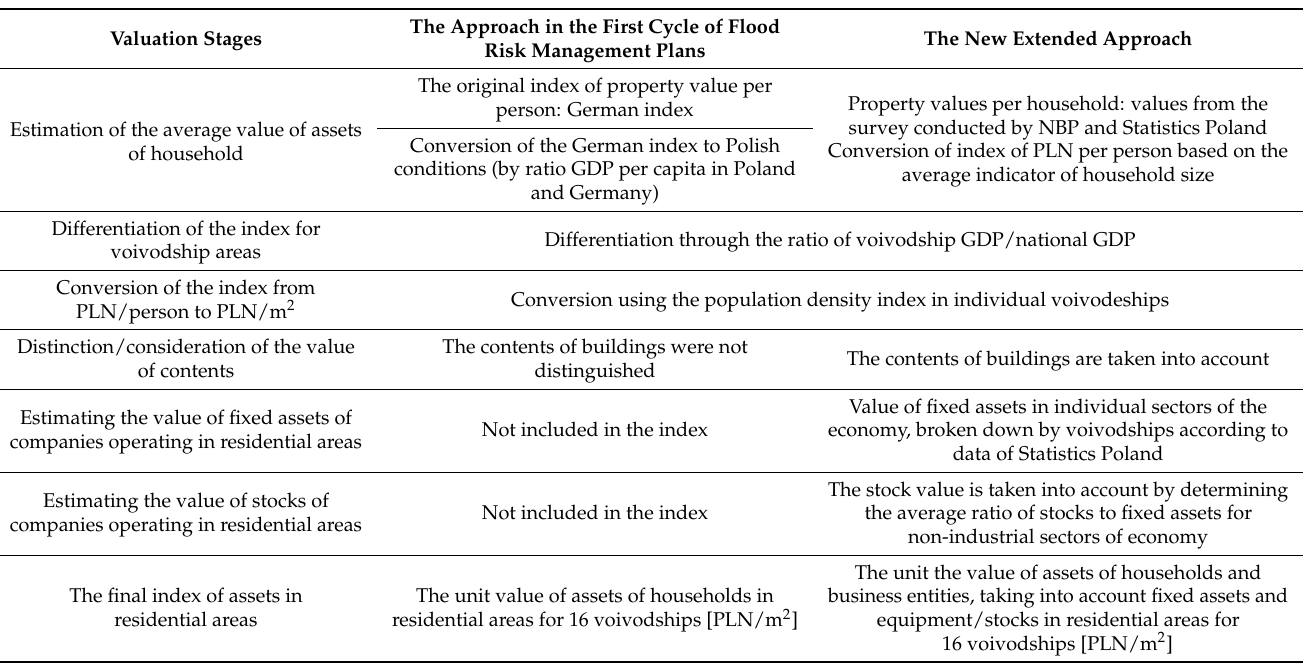
Table 1. Proposed changes in the approach to asset valuation in residential